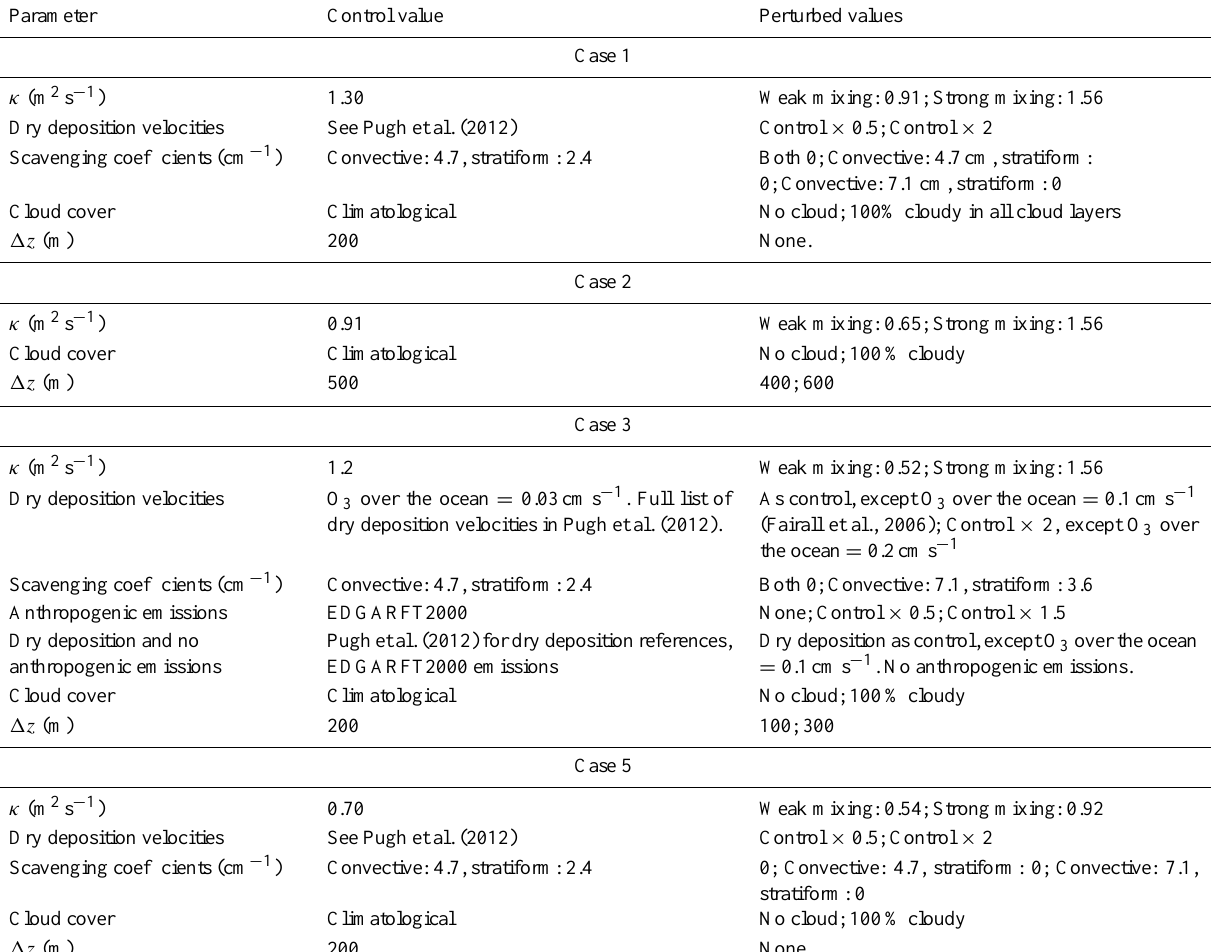
Table 1. Sensitivity tests for the ITCT-Lagrangian 2004 cases. Parameter Control